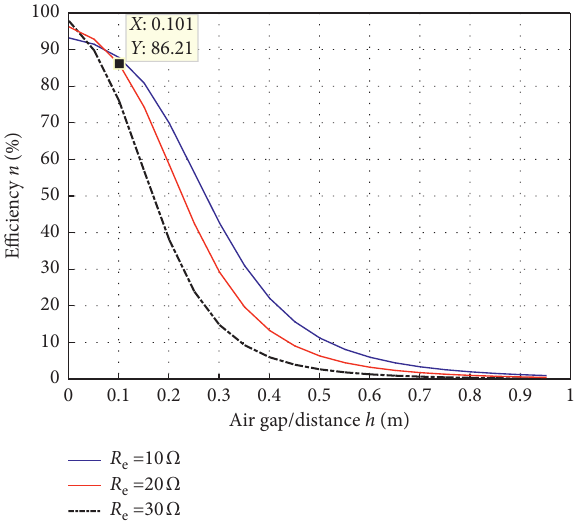
Figure 8: Simulation results showing a reduction of transmission efficiency with increased air gap between